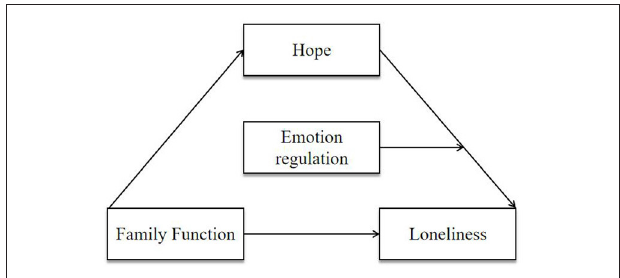
FIGURE 1 | The proposed theoretical model between the interest variables.